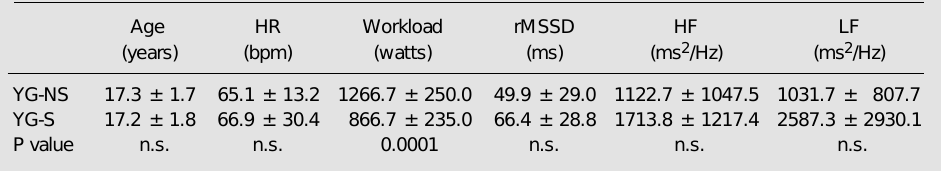
Table 2 - Mean values of age, HR, achieved workload and HRV indices (rMSSD, HF and LF) for sedentary (YG- S) and nonsedentary (YG-NS) subjects of the young group (YG). Values are reported as mean ± SD (N = 9). The only parameter that showed a statistically significant difference was the achieved workload (see text for discussion). For abbreviations, see legend to Table 1. Age